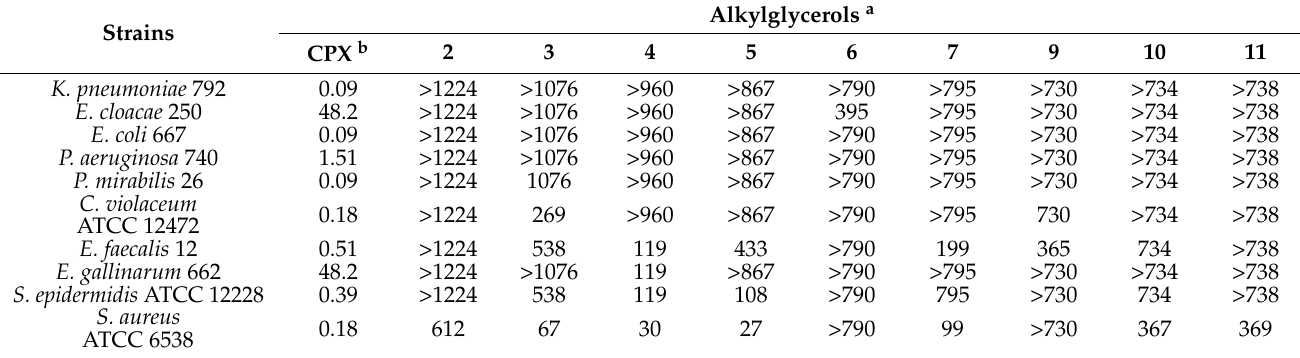
Table 1. Minimal inhibitory concentration values ( µ M) of the examined